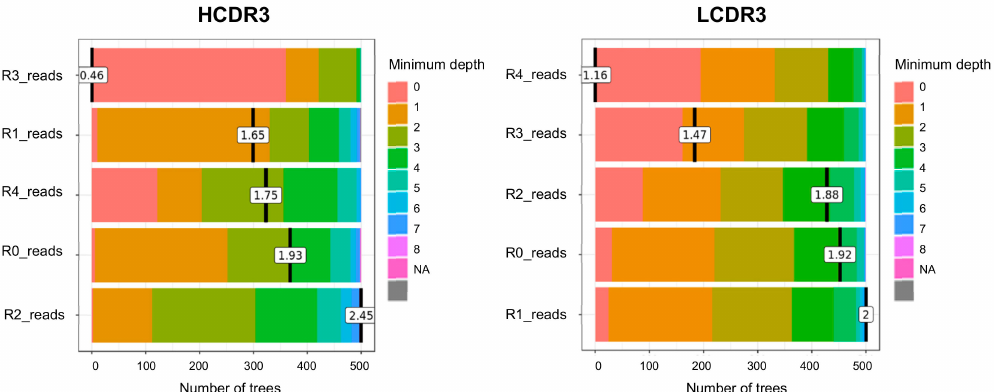
Figure 2. Distribution of the minimum depth of predictor variables (clonal abundance at round 0–4 of bio-panning) from individual decision trees in the RF prediction model for CDR3 clonotypes. Minimum depth value is colored according to its depth and mean value is calculated and displayed at